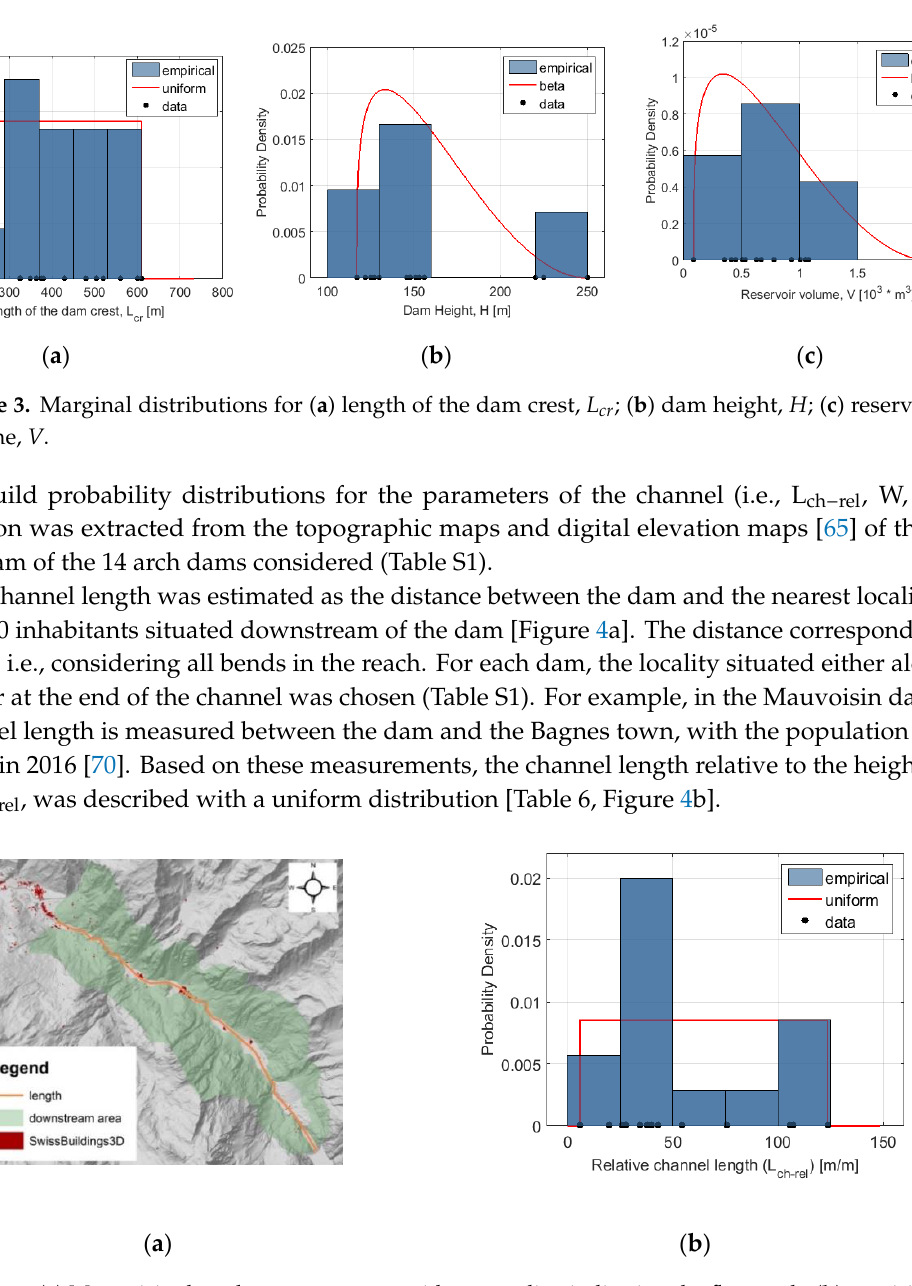
( b ) Figure 5. ( a ) Mauvoisin dam downstream area with the valley bed (pink area) and lines indicating its width at different locations; ( b ) empirical data on the averaged width of the channel bed, 𝑊 , and distribution fitted to the data. To define the channel side slope 𝑆 𝑠 for each individual valley the following steps were performed, as shown for the case of the Mauvoisin dam in Figure 6a–c. First, the polygon of the valley embankments was drawn [Figure 6a, green polygon]. This polygon indicated the area that is lying below the mountain ridge forming the sides of the valley, but that is not included in the polygon of the valley bed [Figure 6a, rose polygon). In the next step, the slope value at each point falling within